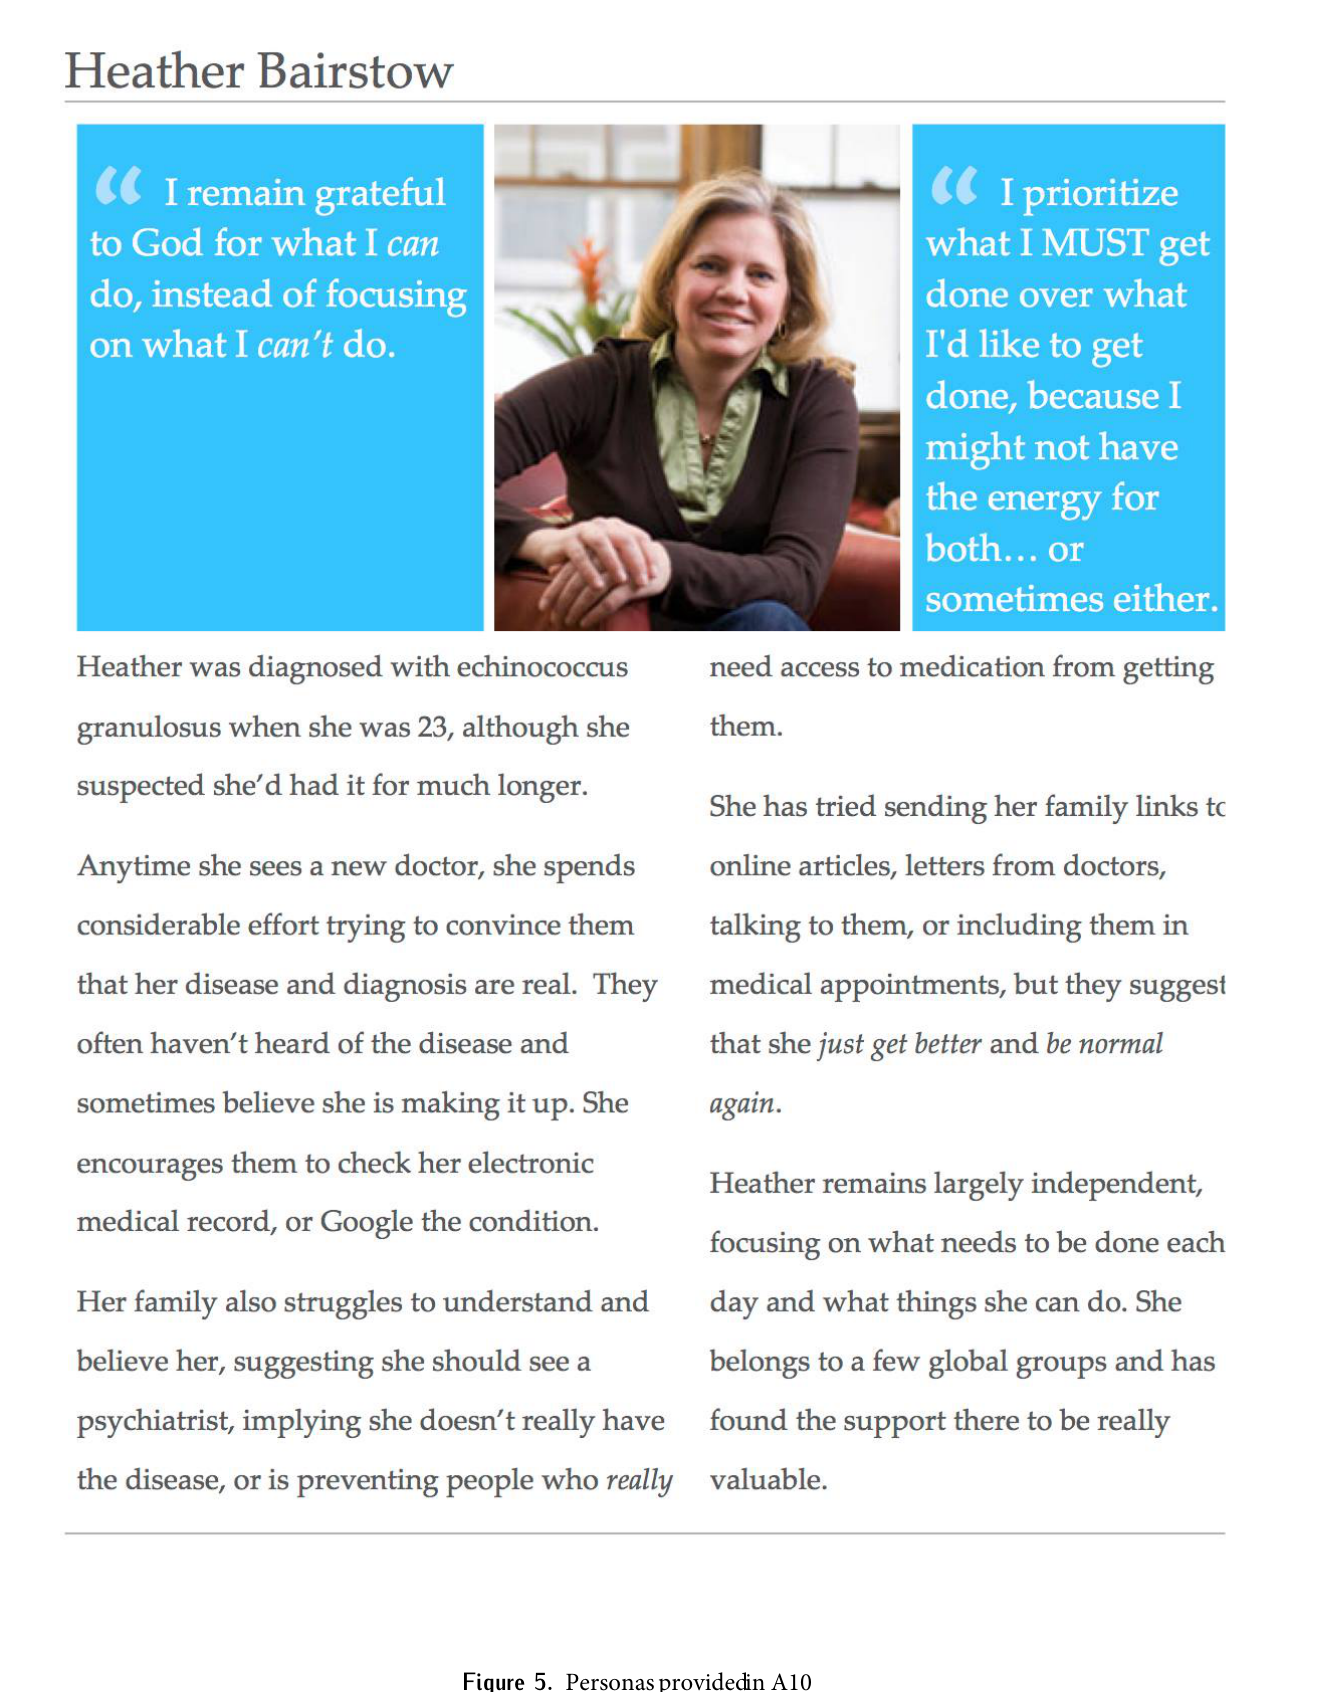
Figure 5. Personasprovidedin